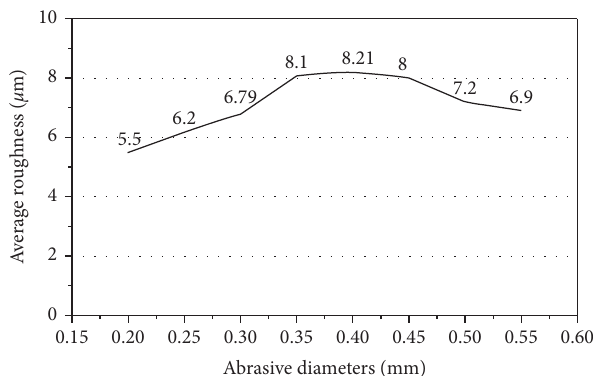
Figure 17: Average roughness curve under different abrasive diameters.